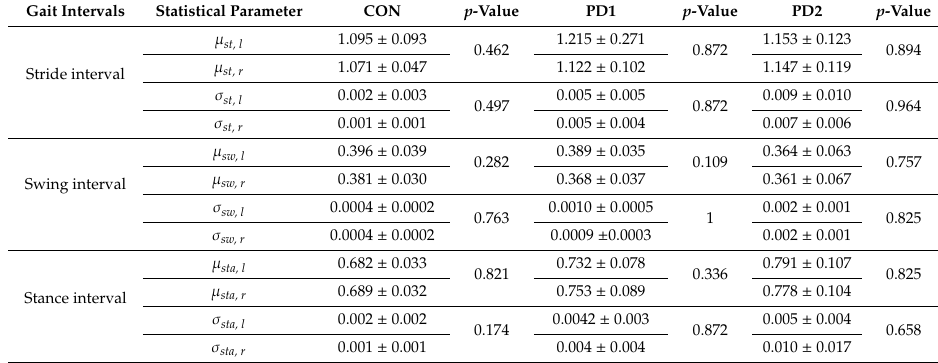
Table 2. Comparison between left and right leg mean ( ± SD) and variance ( ± SD) of gait parameters for di ff erent